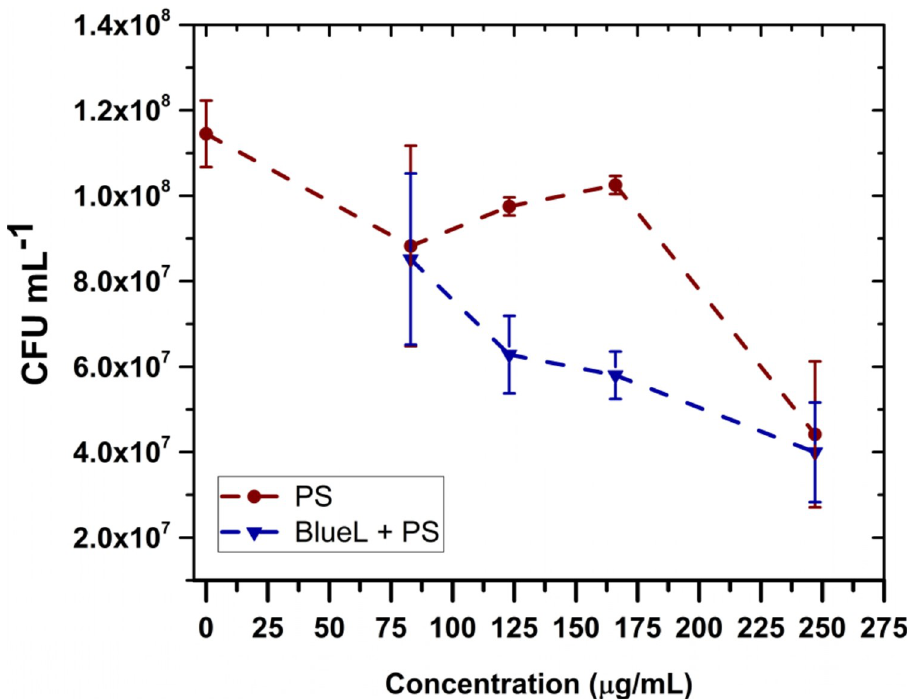
Fig 4. Toxicity and photoinactivation effect of pheomelanin nanoparticles. Dark toxicity (circles) and bactericidal effect (triangles) of pheomelanin nanoparticles at different concentrations against E . coli exposed 1 h to blue light. Values represent averages ± standard deviations of three different experiments.